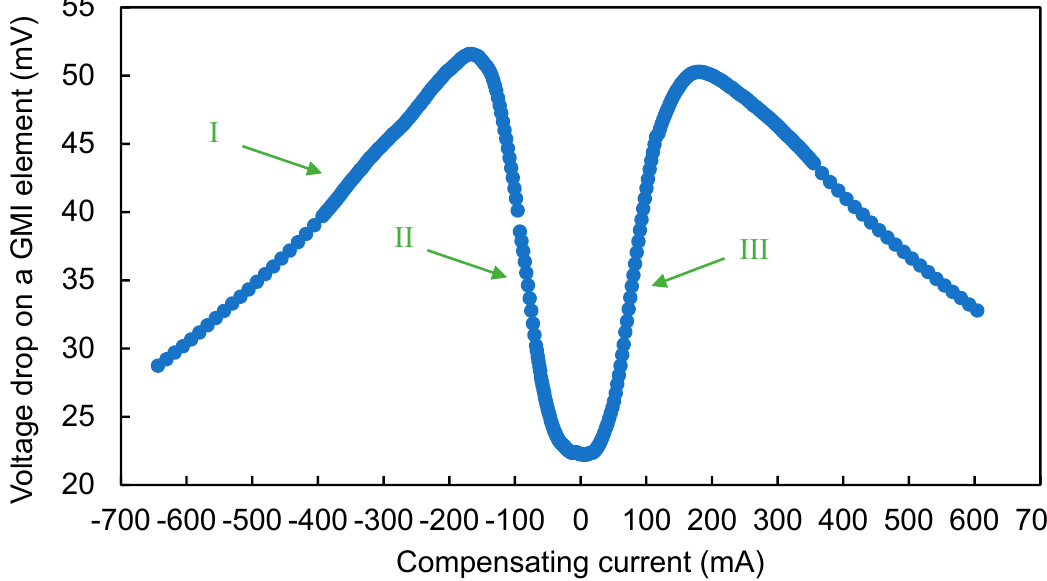
Figure 10. Voltage drop on the GMI sensor’s core as a function of compensating current. I—First rising slope in sequence, II—first falling slope in sequence, III—second rising slope in